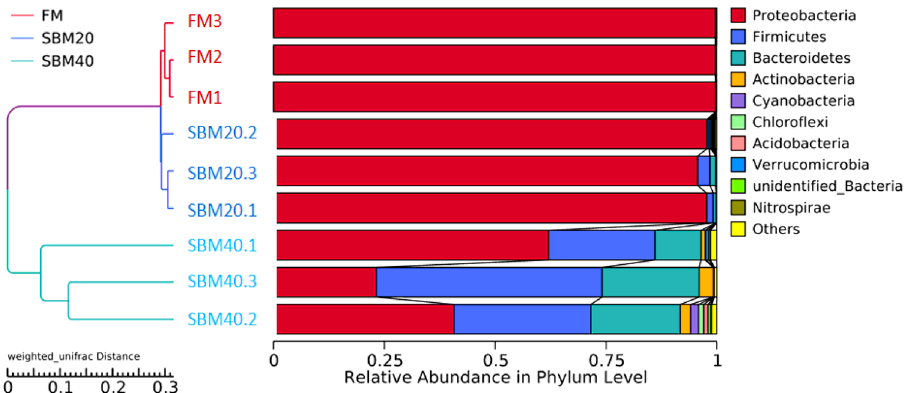
Figure 5. UPMGA clustering analysis of all samples based on the Weighted-Unifrac distance matrix at phylum level (n = 3).